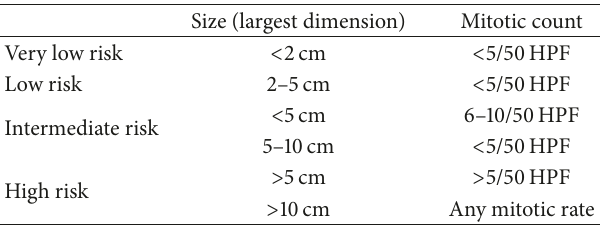
Table 1: Fletcher et al. prognostic